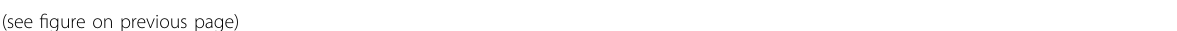
Fig. 7 Antitumor effect and schematic diagram of cancer cell death by TGF- β downregulation. a BALB/c athymic nude mice were injected with 8 × 10 6 A375 or HPAC cells in 100 μ L. When the tumors reached an average size of 60 – 80 mm 3 , the nude mice received intratumoral injections of 1 × 10 9 plaque-forming units (pfu) of various kinds of adenovirus (Ad-NC, Ad-shTGF- β 1, or Ad-shTGF- β 2) in 50 μ L of PBS or PBS alone on days 1, 3, and 5. Tumor volume was monitored and recorded every 2 days until the end of the study. Values represent the mean ± SE ( fi ve animals per group) (top). Asterisks indicate a signi fi cant difference compared to each given control (* p < 0.05; ** p < 0.01). Overall survival was determined throughout a 31-day time course (bottom). b Representative immunohistochemical analysis of recombinant adenovirus-infected tumor sections was performed as follows. Three animals per group of BALB/c athymic nude mice were injected with 8 × 10 6 A375 or HPAC cells/100 μ L and treated with intratumoral injections of 1 × 10 9 pfu/50 μ L of various types of adenovirus (Ad-NC, Ad-shTGF- β 1, or Ad-shTGF- β 2) on days 1, 3, and 5. Tumors were collected on day 11 for histological analysis. Paraf fi n sections of tumor tissue were stained using anti-Hexon, anti-TGF- β 1, and anti-TGF- β 2 antibodies. c A TUNEL assay was performed on tissue sections to quantify apoptotic cell death, as described in the “ Materials and methods ” section. The percentage of TUNEL-positive cells was determined by counting the TUNEL-positive cells under 10 noncontinuous low-power fi elds. d TGF- β 1 or - β 2 downregulation can cause both NOX4-mediated ROS production and a reduction in Smad complexes (phospho-Smad2, 3 with Smad4) that translocate to the nucleus to bind to gene promoters for the expression of Trx/GSTM1. ROS triggered by decreased Akt activity can dissociate Trx